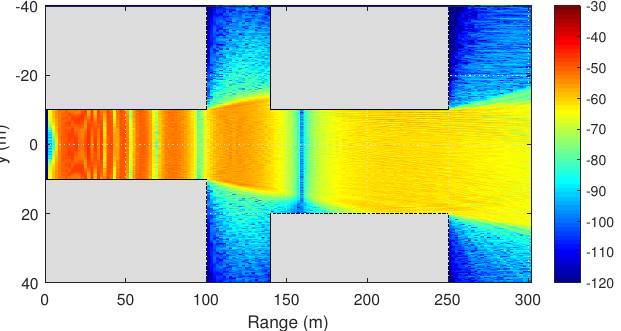
Figure 10. Propagation in a crossroad. Two-dimensional distribution of the signal level (dBm) at the height of 1.5 m, calculated by the one-way PE method.